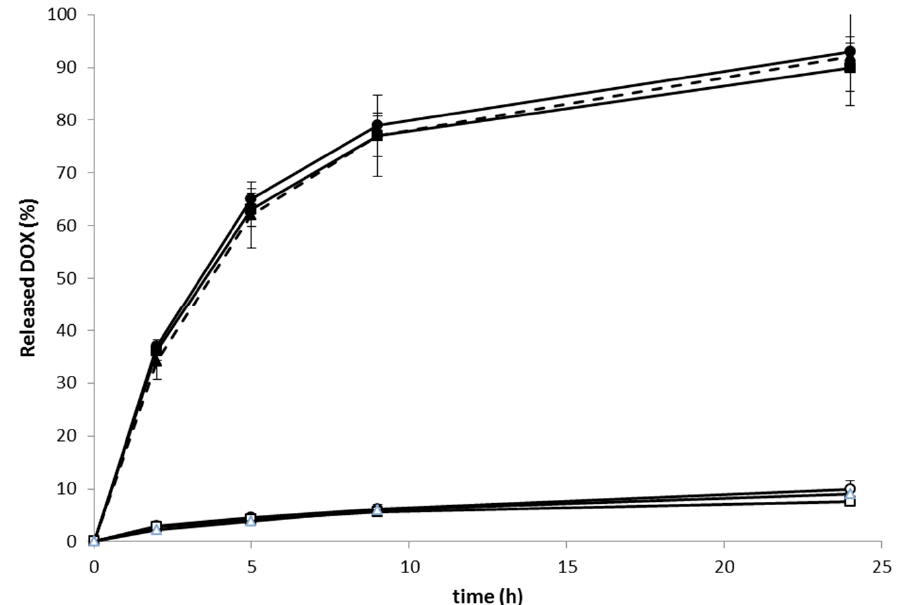
Figure 3. Release of DOX from linear, star and RTX containing polymer-DOX conjugates incubated in phosphate buffers at 37 °C: ( ● ── ) Pol-DOX , pH 5; ( ▲ - - - ) Pol(Star)-DOX , pH 5; ( ■── ) RTX-Pol-DOX , pH 5; ( ○── ) Pol-DOX , pH 7.4; ( ∆── ) Pol(Star)-DOX , pH 7.4; ( □── ) RTX-Pol-DOX , pH 7.4; n = 3.